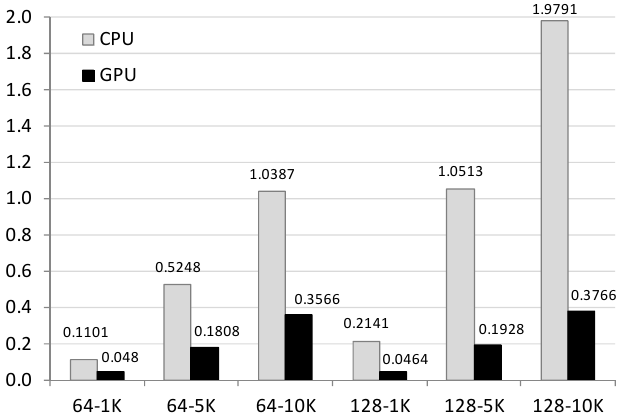
Figure 11. CPU and GPU times for Eil76 (in ms) with respect to different populations (64 and 128) and iterations (1000, 5000, and 10,000).